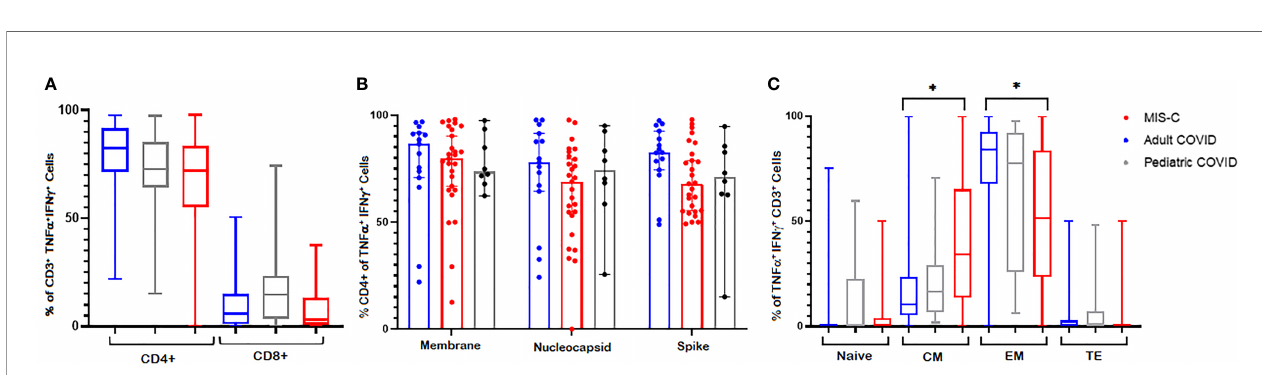
FIGURE 4 | CST response in adults and children with and without MIS-C. (A) Percent of CD3+ T lymphocytes from convalescent adult (blue), non-MIS-C pediatric (gray), and MIS-C (red) subjects secreting TNF- a and IFN- g when stimulated with actin (negative control) or viral antigen post ex vivo expansion in the presence of viral peptides. (B) Membrane (mem), nucleocapsid (NC), and spike peptides induce TNF- a and IFN- g CST secretion. Columns, medians, error bars, 95% con fi dence